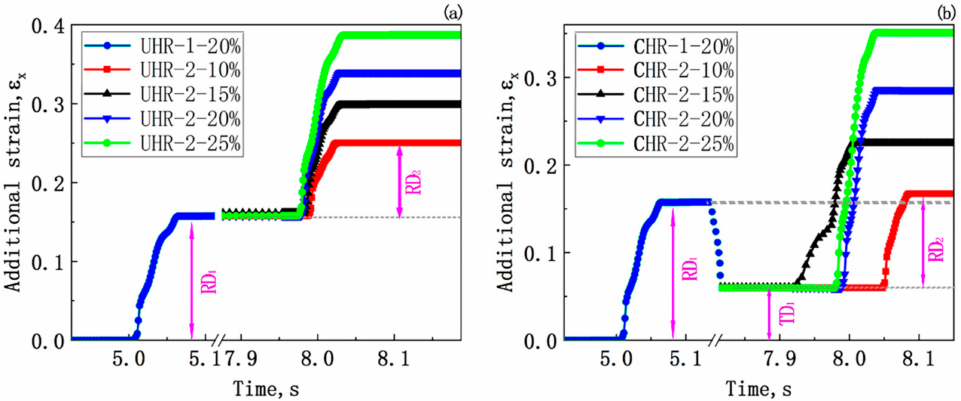
Figure 10. Effect of different reductions on plastic strain at a point on the plate surface along x-direction: ( a ) UHR; ( b )